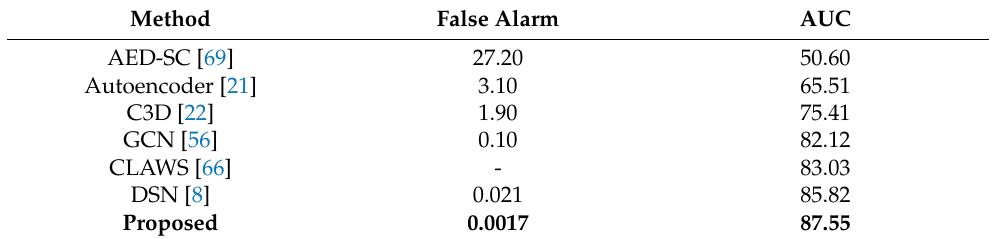
Table 1. Performance comparison of the proposed model with other SOTA over UCF dataset.